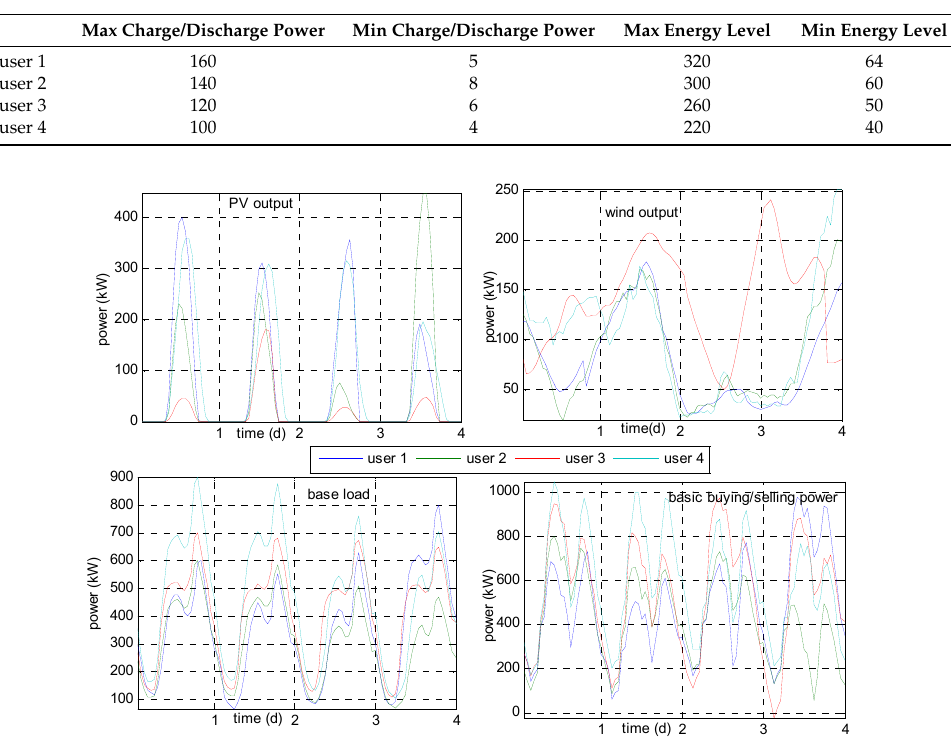
Figure 2. PV and wind generation, base load demand and the basic buy/selling power for each user.